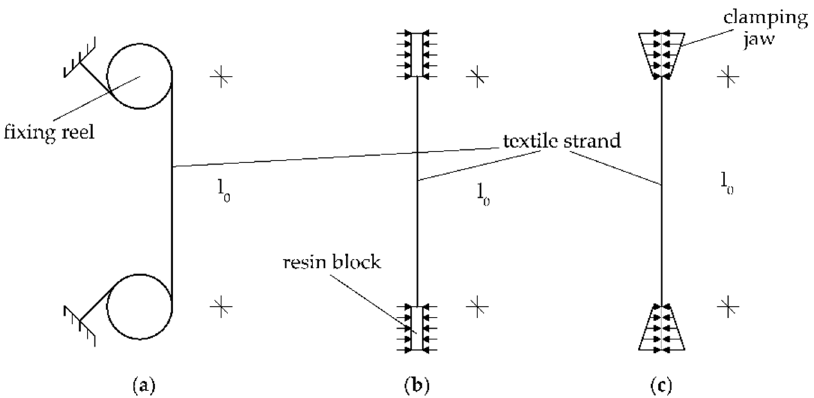
Figure 5. Test setups for testing the tensile strength of fiber strands: ( a ) fixing reels for soft impreg- nated strands; ( b ) strand with epoxy resin blocks for load introduction; ( c ) clamps with increasing clamping pressure.